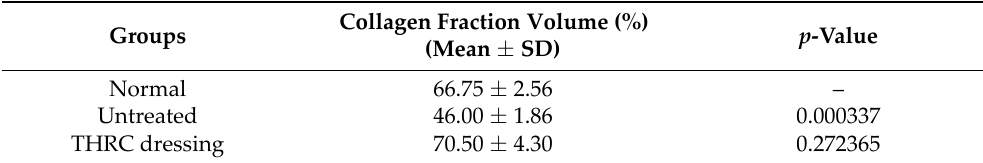
Table 2. Collagen fraction volume of skin tissues in the normal, untreated, and THRC dressing groups.